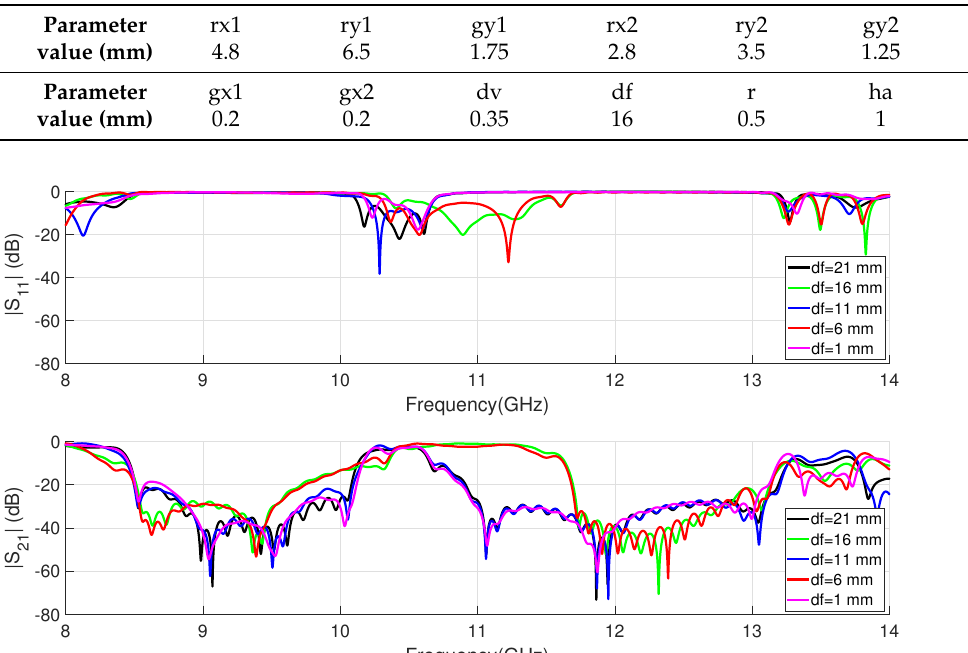
Table 1. Parameters of the dual-band EBG IM-GWG filter.